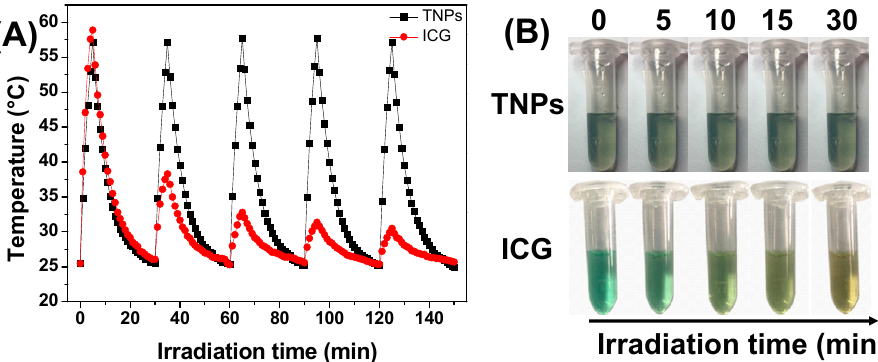
Figure 6. ( A ) Temperature elevation of TNPs, and free ICG under five irradiation/cooling cycles (under 880 nm irradiation at 0.7 W/cm 2 for 5 min), ( B ) Photographs of the TNPs, and free ICG in PBS solutions after 880 nm light irradiation for different time.